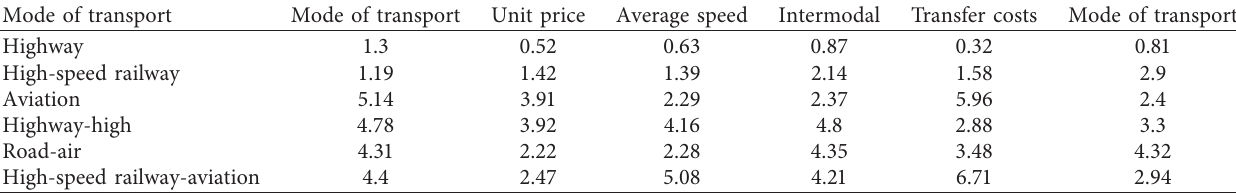
Figure 14: Unit price, transit time, and cost for each mode of Table 16: Unit price, transit time, and cost for each mode of transportation.